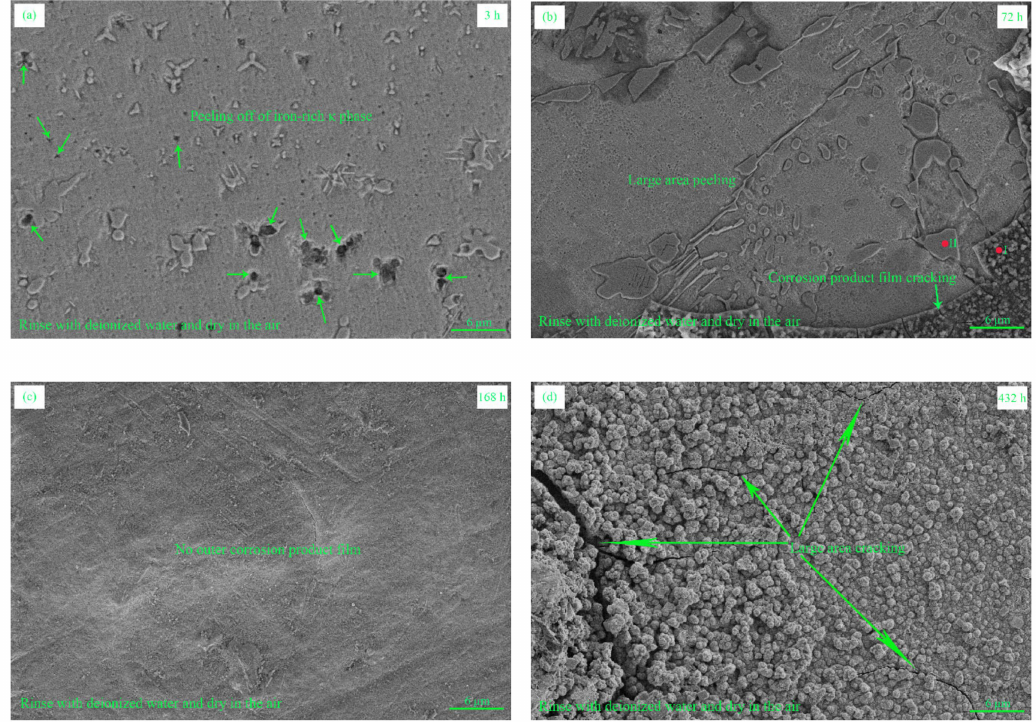
Figure 9. SEM images of CDS immersed in 3.5% NaCl solution at di ff erent times: ( a ) 3 h; ( b ) 72 h; ( c )168 h; and ( d ) 432 h. Table 2. The composition of DFS, WRS and CDS immersed in 3.5% NaCl solution for 72 h. Element Content Position